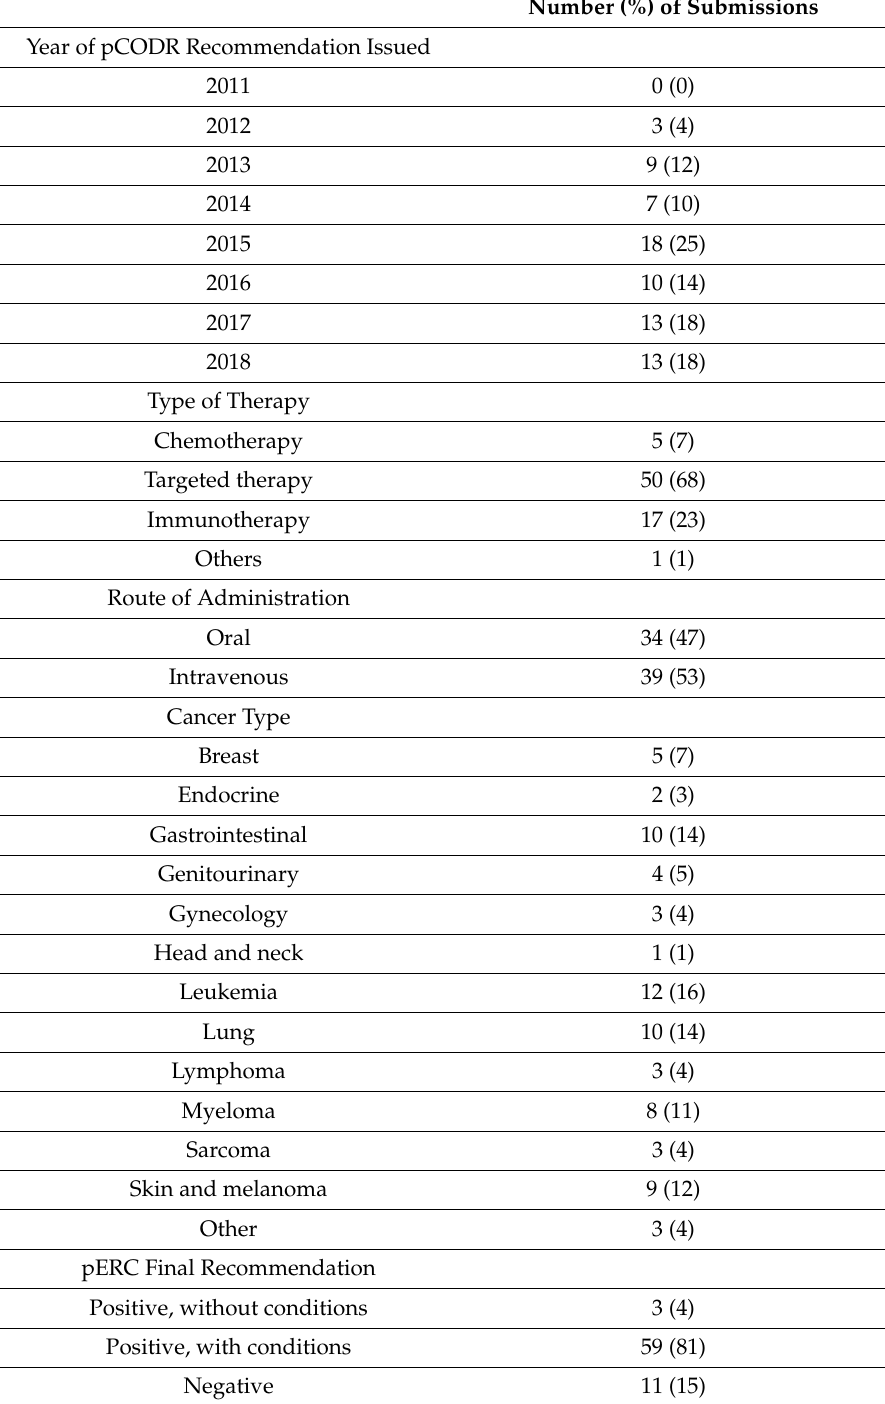
Table 1. Key characteristics of the included submissions. Number (%) of